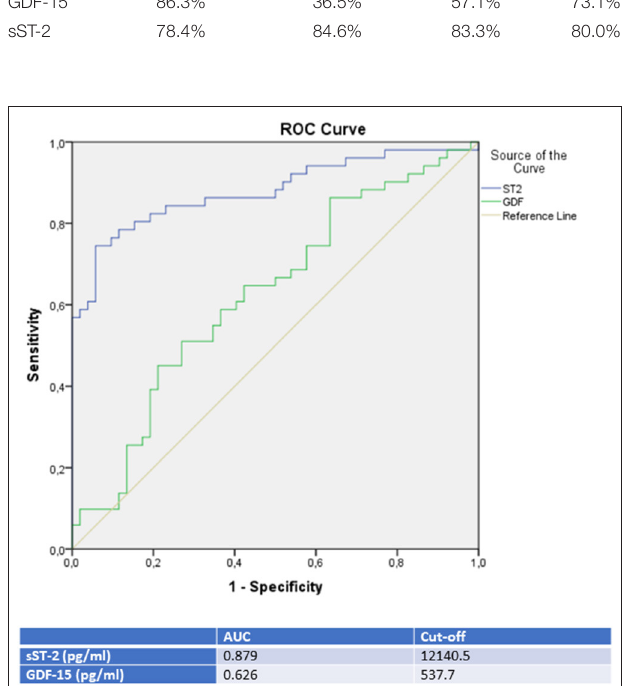
indicators for patients presenting with de novo heart failure in